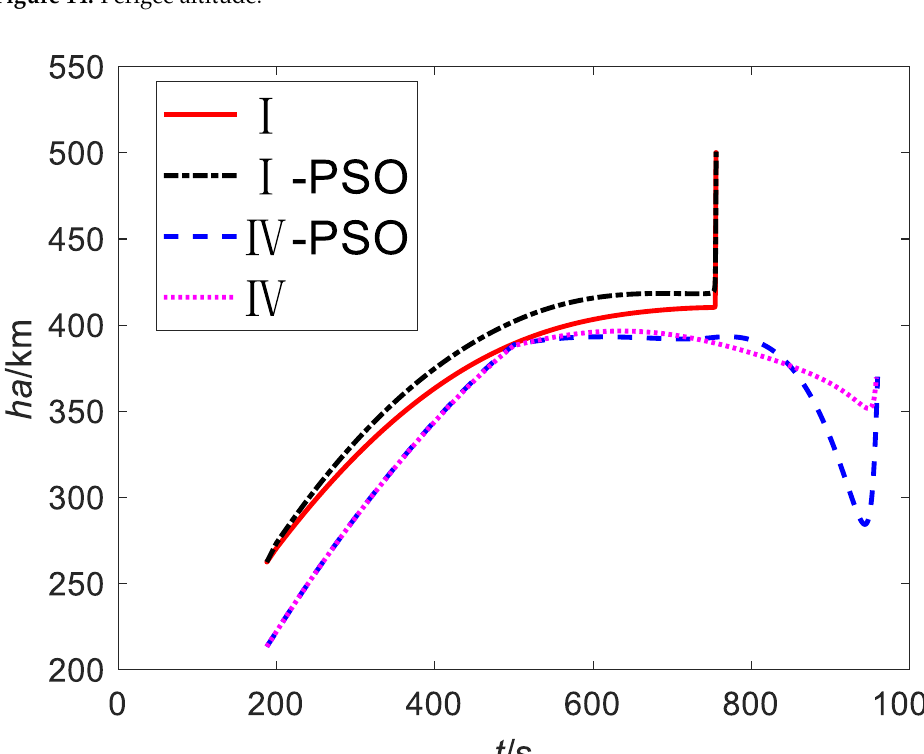
Figure 14. Perigee altitude.